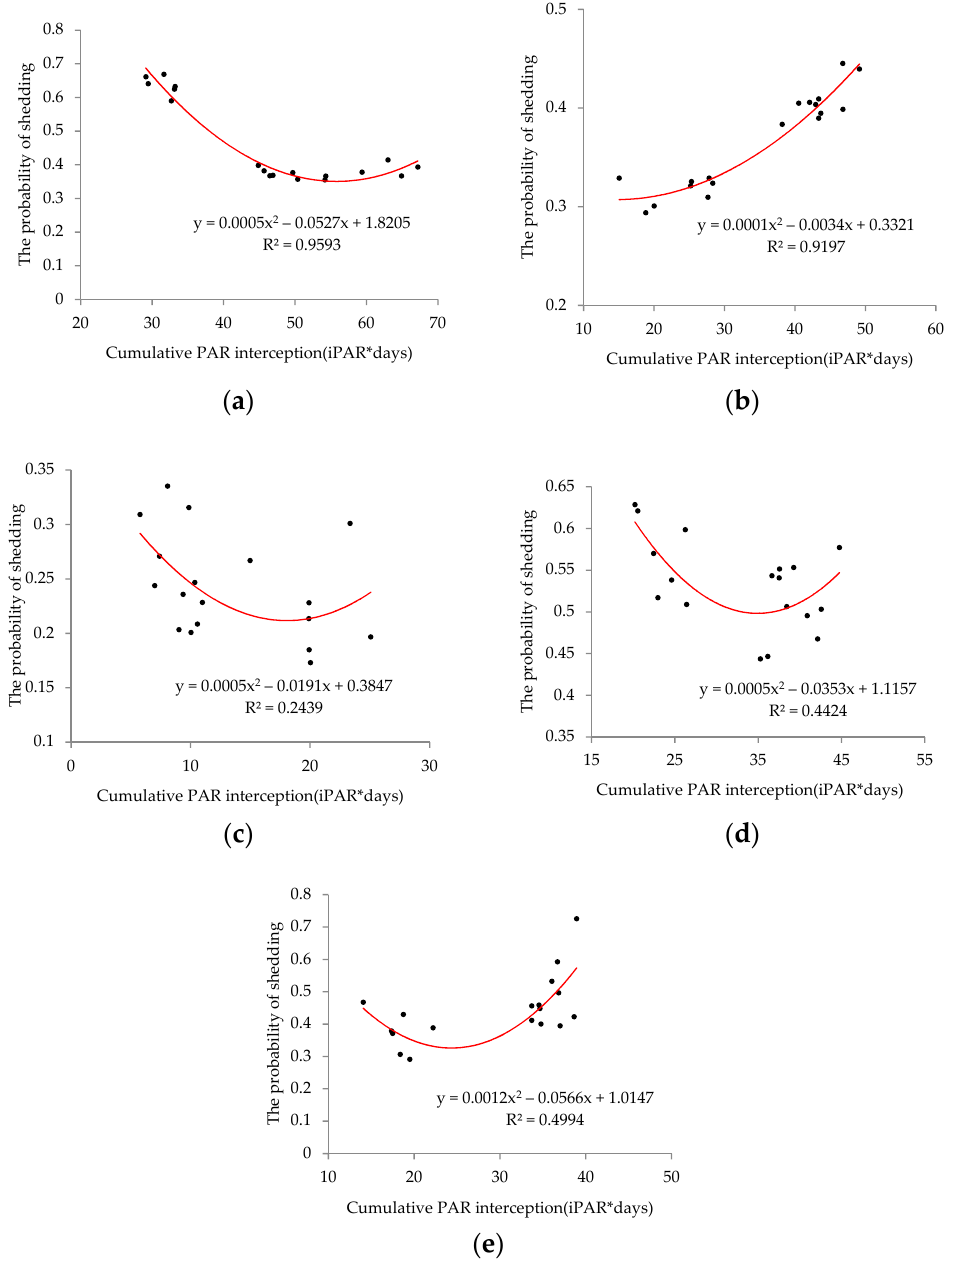
Figure 11. Relationships between cumulative light interception and the boll shedding rate in the corresponding section. ( a ) Lower; ( b ) Middle; ( c ) Upper; ( d ) Inner; ( e ) Outer. iPAR*days means iPAR's integral of the number of growth days.